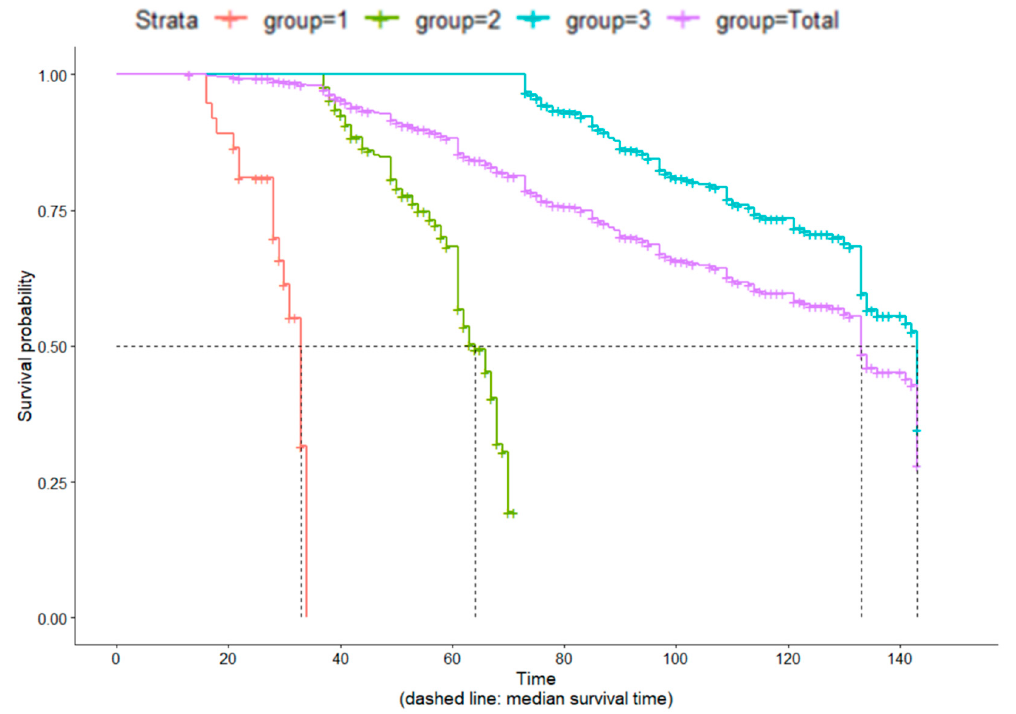
Figure 1. Survival curves based on career duration of nurses. The purple line denotes all nurses (group = total). The red line denotes competent nurses (group = 1). The green line denotes proficient nurses (group = 2). The blue line denotes expert nurses (group = 3). Table 2. Results of the time-independent Cox proportional hazard